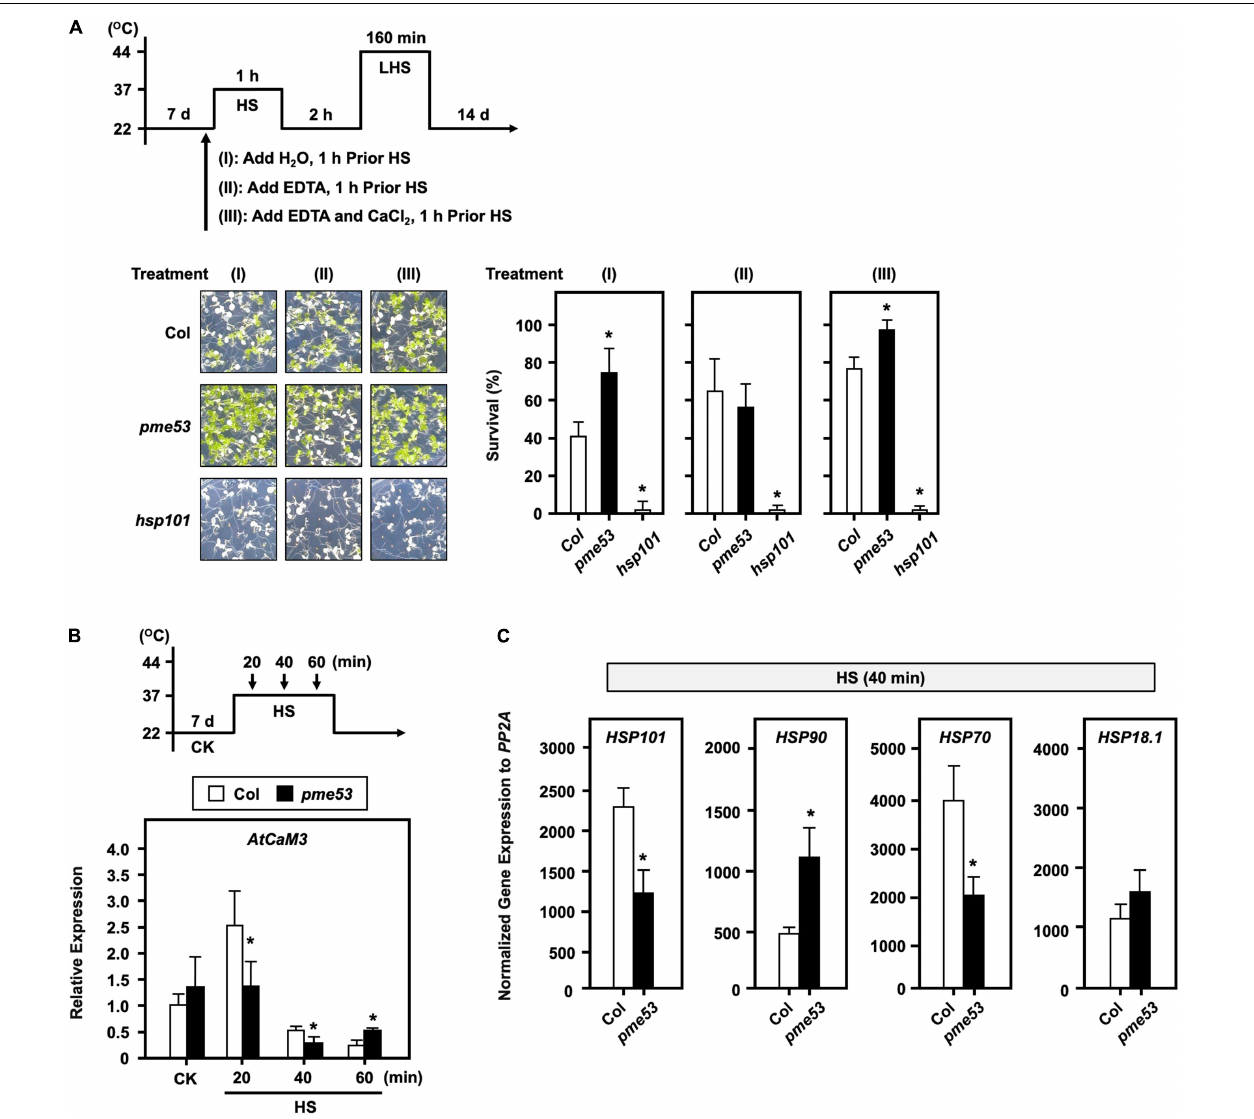
FIGURE 9 | The effect of EDTA and Ca 2 + on the phenotype of pme53 plants and expression levels of AtCaM3 in response to heat stress. The pictogram shows the heat stress regime. (A) Seedlings were applied with 2.5 mL H 2 O, 20 µ M EDTA, or 20 µ M EDTA with 15 mM CaCl 2 solution, 1 h before HS treatment. Seedlings were photographed and survival was measured at 14 days after 44 ◦ C-LHS treatment. hsp101 , a heat-sensitive mutant, was used as reference. Data are mean ± SE of three biological replicates ( n = 50 seedlings). *Significant at P < 0.05 compared with the Col. (B) 7-day-old seedlings in response to 37 ◦ C HS for 20 to 60 min. The expression levels of AtCaM3 were analyzed by q-PCR. The fold change expression was normalized relative to the level of Col control (CK). (C) The expression levels of heat-responsive genes after 40-min 37 ◦ C HS were analyzed by q-PCR. Data are mean ± SE of three biological replicates. *Significant at P < 0.05 compared with the